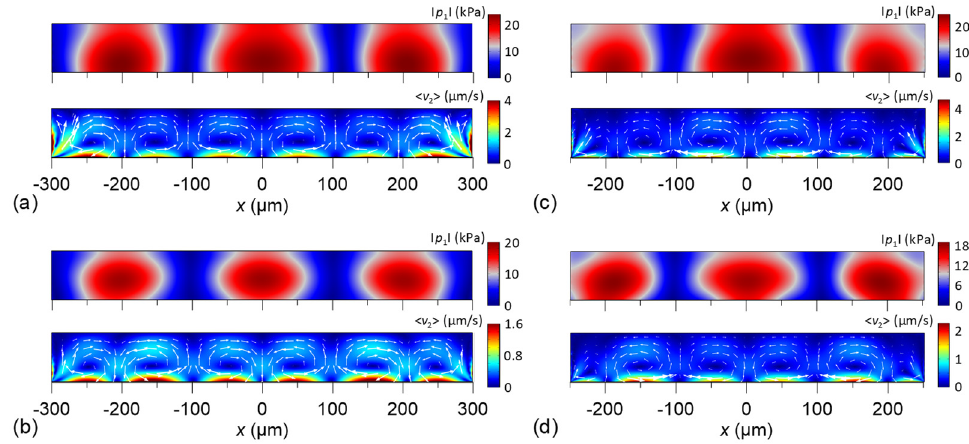
Figure 7. Simulated absolute acoustic pressure | p 1 | and time-averaged acoustic streaming fields (cid:104) v (cid:105) on the channel cross-section induced by the standing A0 and S0 modes for the channel widths w = 600 and 500 µ m. ( a ) A0 mode, w = 600 µ m; ( b ) S0 mode, w = 600 µ m; ( c ) A0 mode, w = 500 µ m; ( d ) S0 mode, w = 500 µ m.